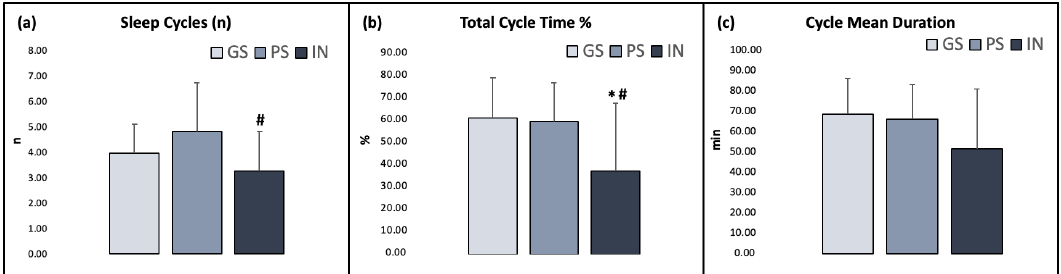
Figure 4. Sleep organization measures in the three groups. ( a ) Number of sleep cycles; ( b ) total cycle time (TCT) %; ( c ) cycle mean duration. Asterisks indicate significant differences relative to the GS group (*: p ≤ 0.05). Hashtags indicate significant differences relative to the PS group (#: p ≤ 0.05). Error bars represent standard deviation.